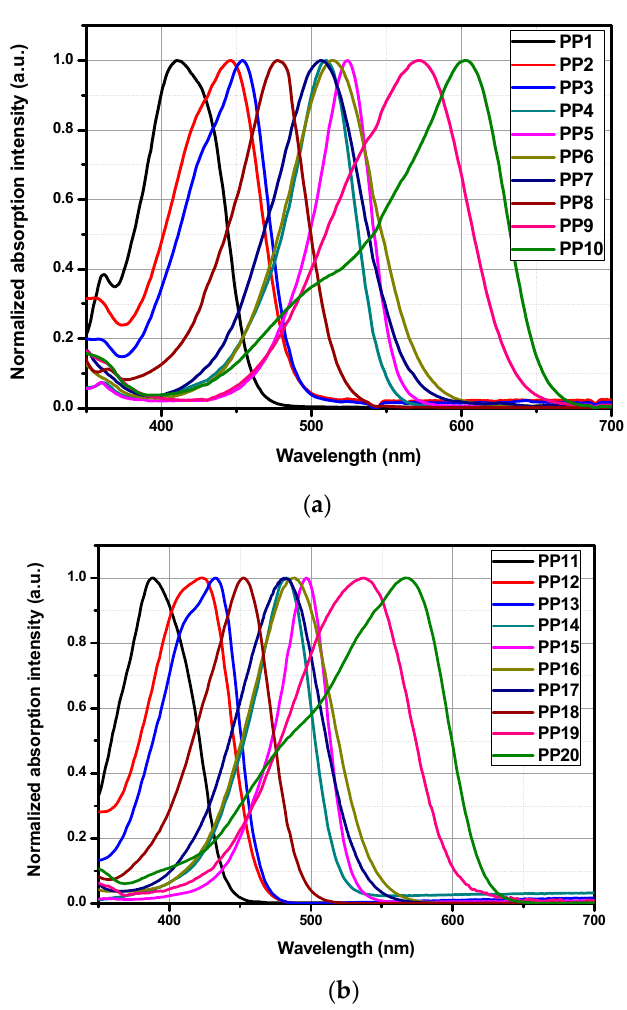
Figure 7. UV-visible absorption spectra of PP1 – PP10 ( a ) and PP11 – PP20 ( b ) in dichloromethane.